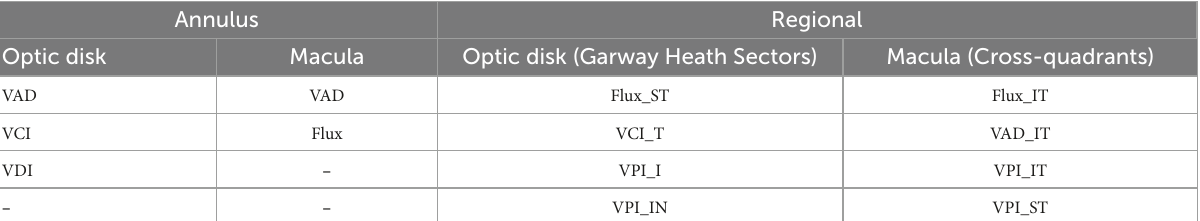
TABLE 4 Logistic regression results with the most predictive annulus and regional optical coherence tomography angiography (OCTA) parameters of peripapillary and macular regions of non-arteritic anterior ischemic optic neuropathy (NAION) disease